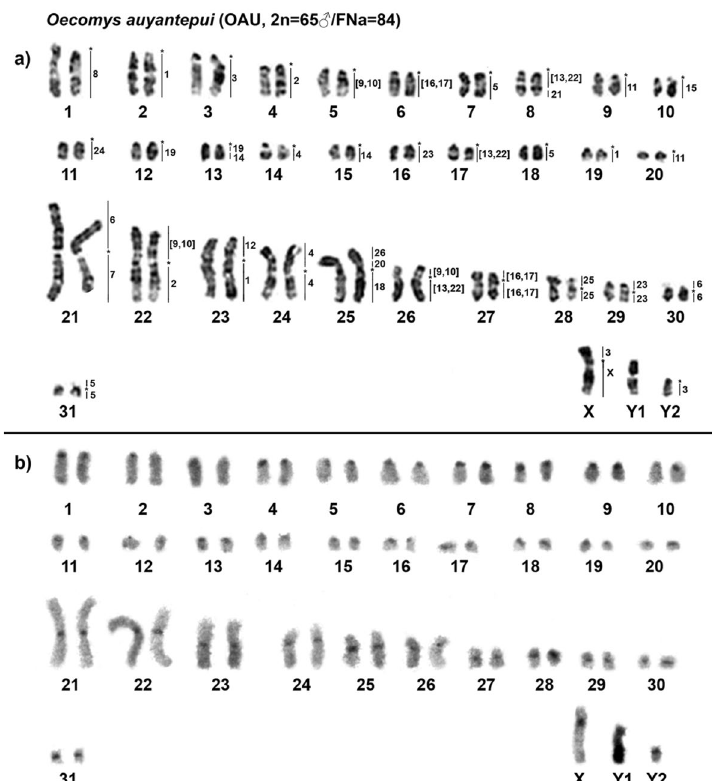
Figure 1. Oecomys auyantepui (2n = 65 ♂ /FNa = 84) ( a ) G-banded karyotype with chromosome painting revealed by Hylaeamys megacephalus (HME) whole chromosome probes 54 , and ( b ) C-banded karyotype. An asterisk indicates a